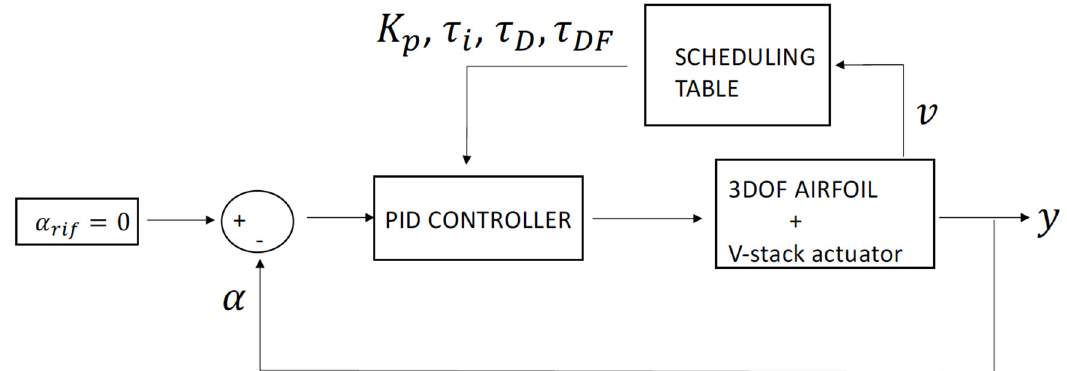
Figure 6. Gain scheduling control architecture.